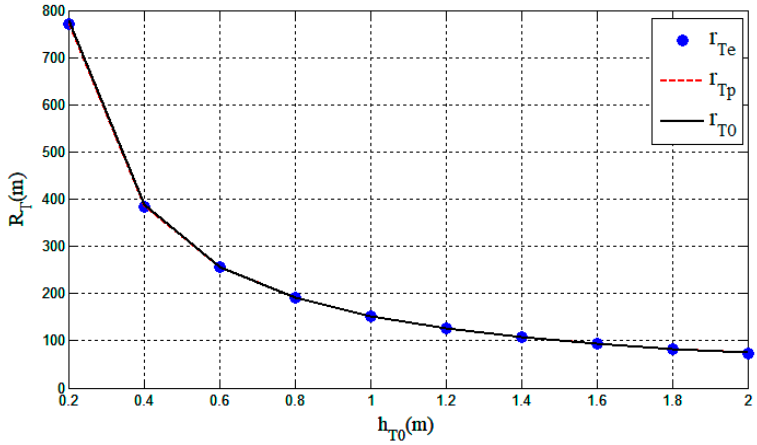
Figure 9. Equivalent radius of a frame structure equipped with SLDTFPB.